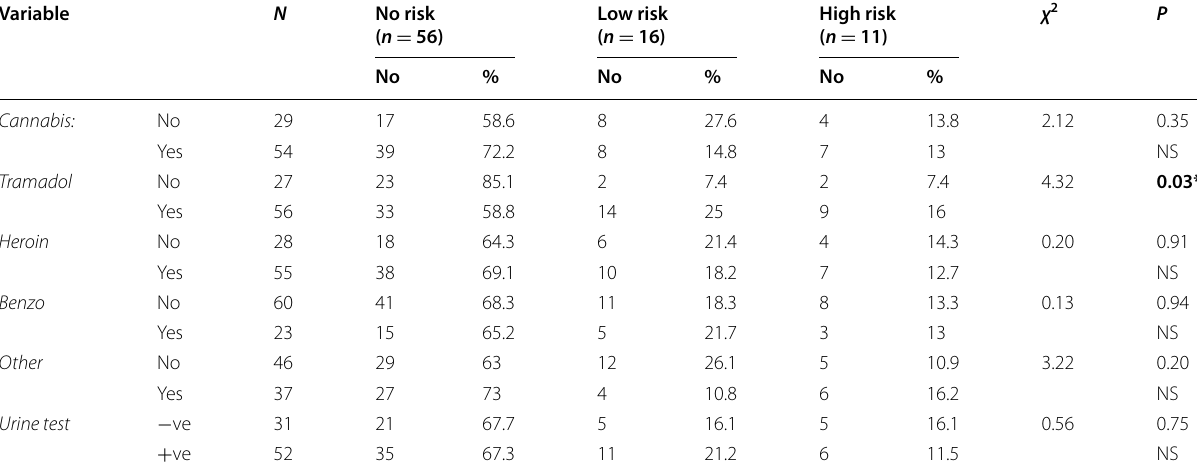
χ 2 chi-square test, NS non-significant ( P > 0.05)